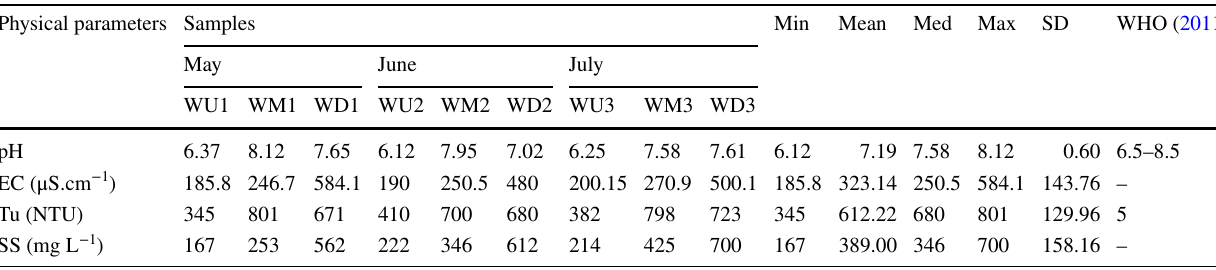
WU Upstream sample; WM Middle of the mining site sample; WD Downstream sample; pH Potential Hydrogen; EC Electrical Conductivity; Tu Turbidity; SS Suspended solids; Min Minimum; Med Medium; Max Maximum; SD Standard deviation; WHO World Human